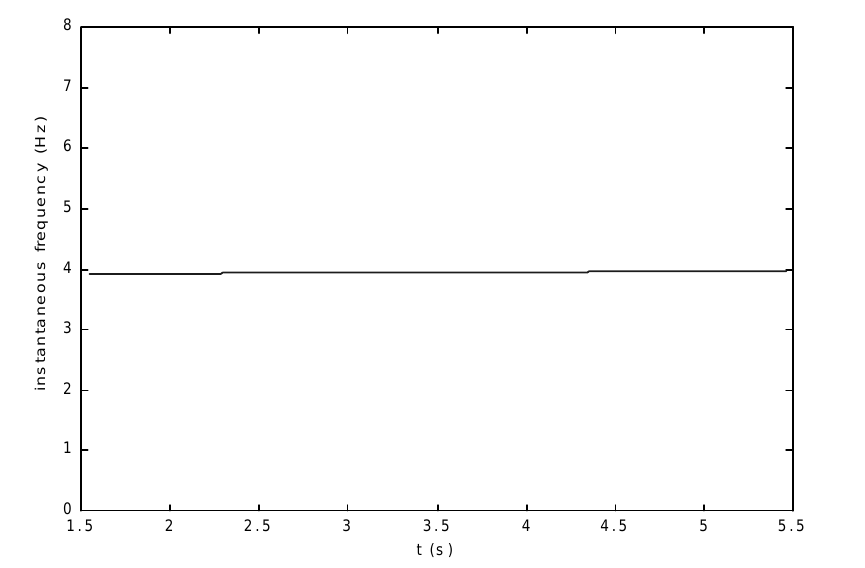
Fig. 3. Evolution of the MSE with the damping order.